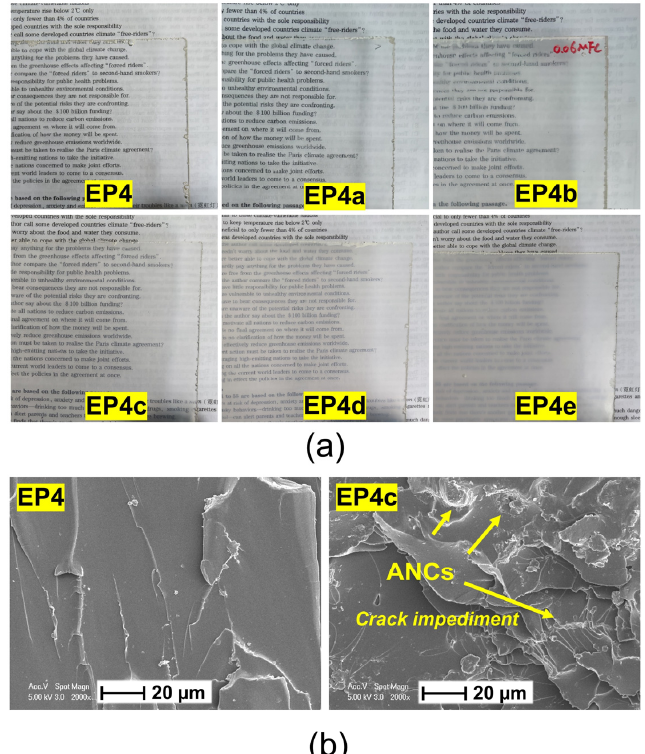
Figure 6. ( a ) Transparency of SMEPNs with different ANCs loading (EP4, EP4a, EP4b, EP4c, EP4d, EP4e, respectively, correspond to 0.00, 0.02, 0.06, 0.20, 0.40, 0.60 wt.% ANCs incorporated in a matrix with mole ratio of epoxy monomer to curing agent 𝜂 = 1.75). ( b ) SEM photographs of fracture surfaces of EP4 and EP4c.